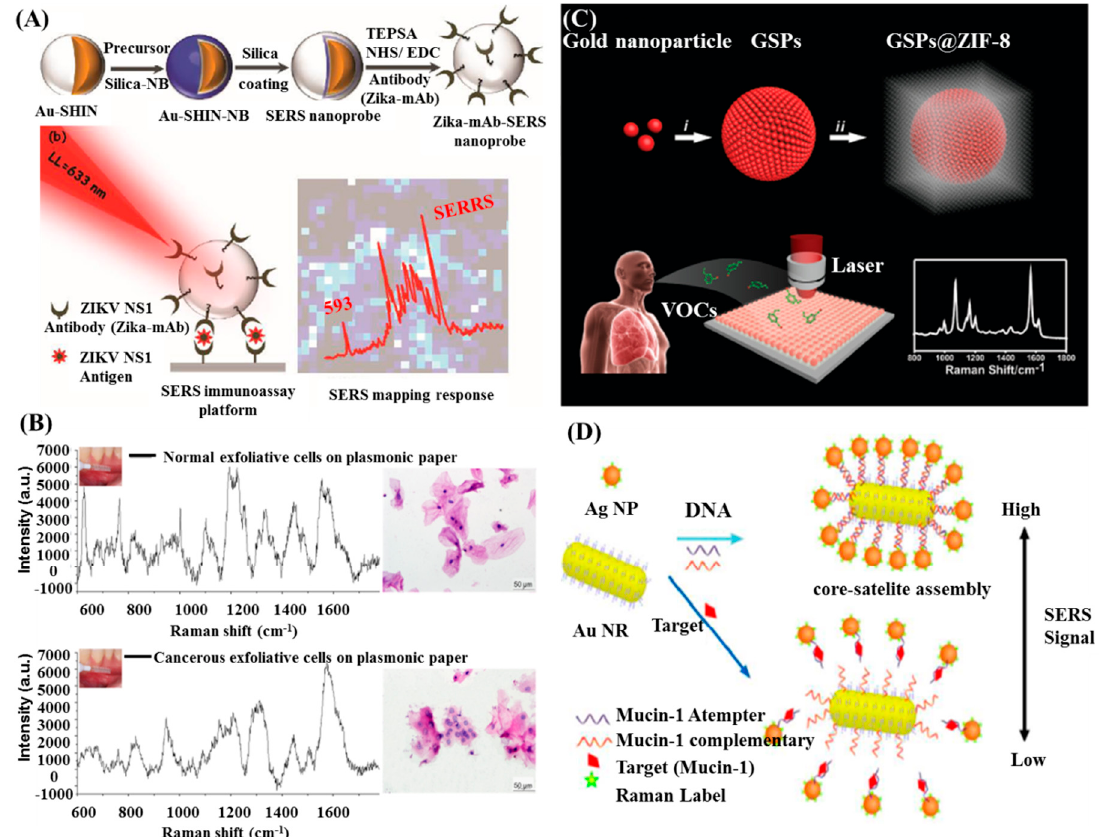
Figure 4. ( A ) Illustration of the SERS immunoassay platform for detecting ZIKV NS 1. Reproduced with permission from reference [91]. ( B ) Cancerous cells screening using the paper-based SERS platform. Reproduced with permission from reference [92]. ( C ) Diagrammatic sketch of synthesizing GSP@ZIF-8 core-shell structure and the volatile organic compounds (VOCs) detection via SERS spectroscopy. Reproduced with permission from reference [93]. ( D ) Scheme of SERS aptasensor for the detection of Mucin-1based on Au NRs-Ag NPs core-satelliteassemblies. Reproduced with permission